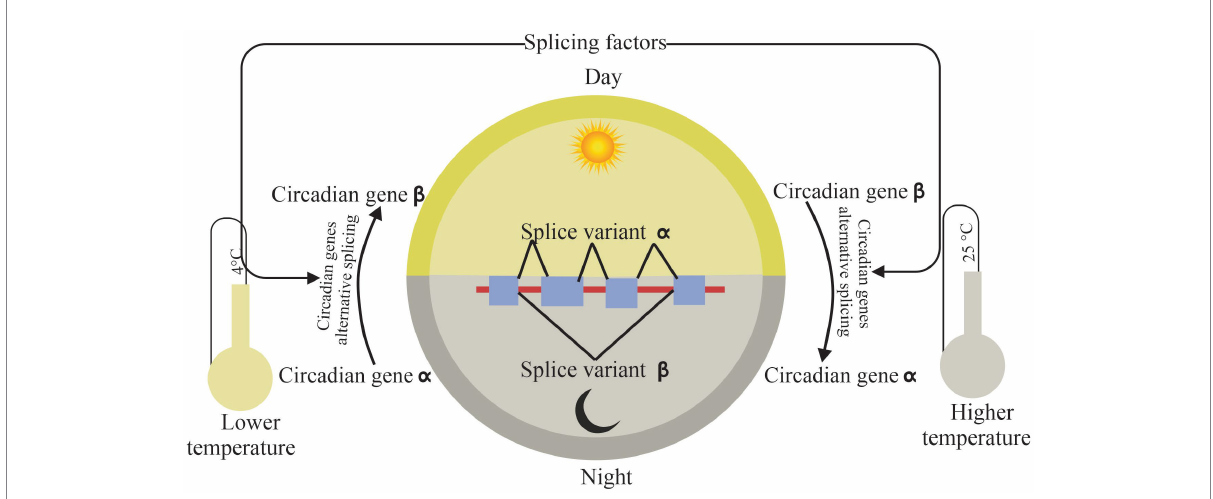
FIGURE 3 Connection of circadian and alternative splicing. Splicing factors affect circadian rhythm by self and core circadian genes splicing under temperature stress, while circadian-mediated alternative splicing according to rhythmic temperature changes in day and night. The arrows indicate the relationship between